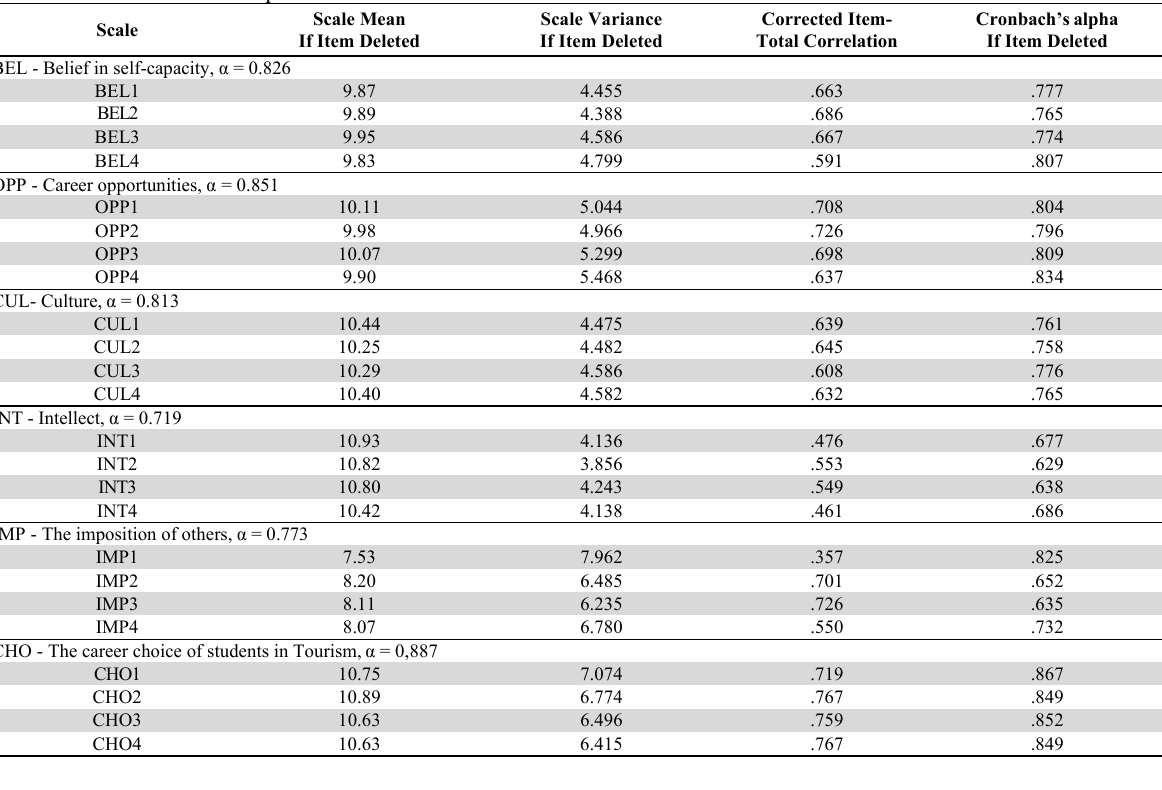
Scale Mean If Item Deleted